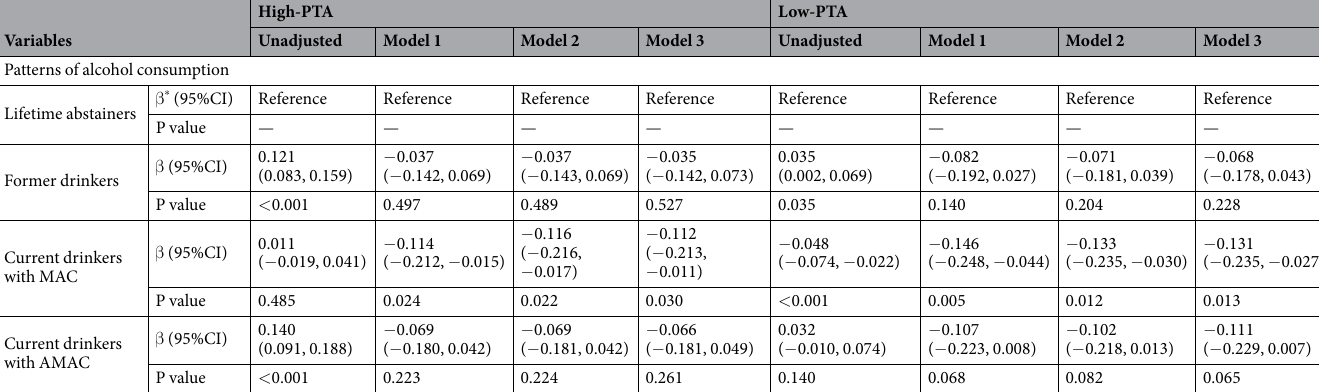
Table 2. Regression coefficients of patterns of alcohol consumption for hearing threshold. Adjusted covariates: Model 1 = age, sex, race. Model 2 = Model 1 + (waist circumference, uric acid, fasting glucose, total cholesterol). Model 3 = Model 2 + (abnormal otoscopy, abnormal tympanometry, present use of ototoxic agents, history of diabetes, heart disease, stroke). Definition of abbreviations: MAC = moderate alcohol consumption, AMAC = above moderate alcohol consumption, High-PTA = Pure tone average at high frequencies, Low- PTA = Pure tone average at low frequencies. * β Coefficients can be interpreted as differences in hearing threshold comparing subjects in the other three patterns of alcohol consumption to those in the lifetime